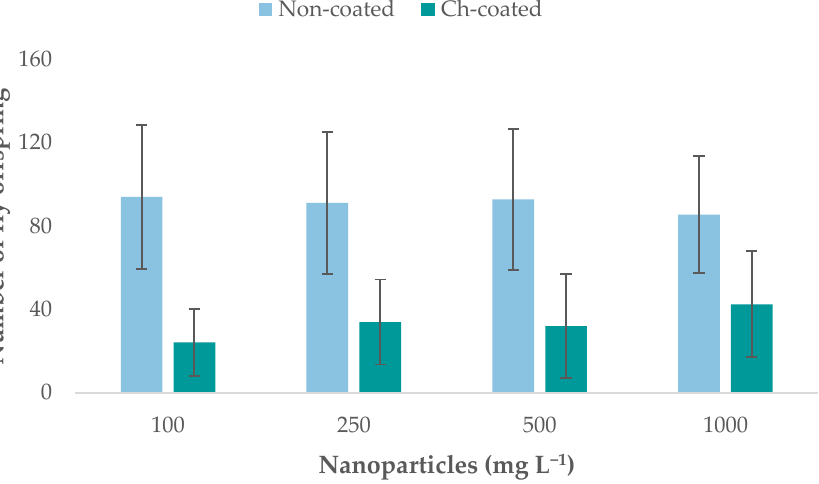
Figure 3. Zeta potential distribution: Fe 3 O 4 NPs (red) and Ch-Fe 3 O 4 NPs (green). 2.2. Fe 3 O 4 NPs’ and Ch-Fe 3 O 4 NPs’ Effects on Drosophila melanogaster Fertility The offspring of crossed flies exposed to Fe 3 O 4 NPs and chitosan-coated (Ch- Fe 3 O 4 NPs) were counted to estimate the effect of four NPs concentrations on the fertility of flies after exposure (Figure 4). The offspring of the control crosses (flies not exposed to NPs) were also counted.